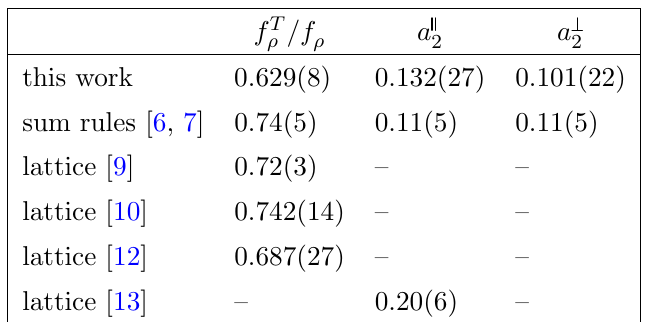
Table 5 . Final results together with QCD sum rule estimates and older lattice QCD data. The renormalization scale is (cid:22) = 2